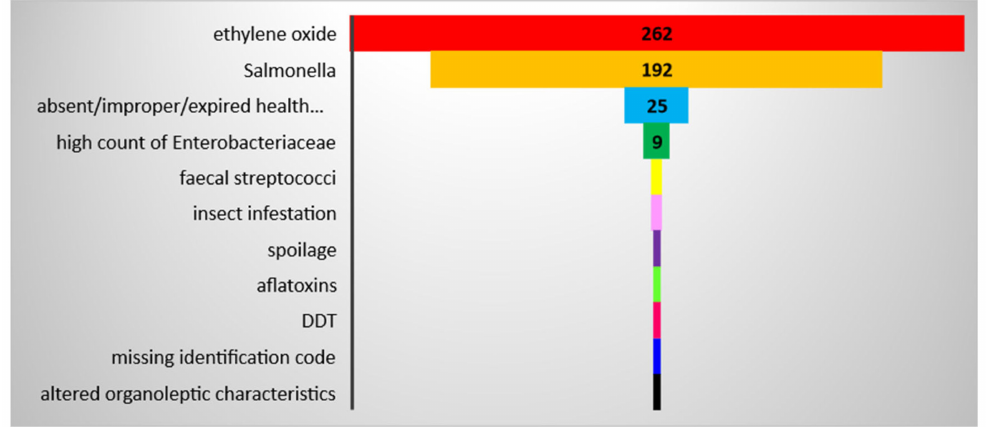
Figure 2. RASFF notifications linked to sesame seeds from India per substance/hazard over the period 1 January 2011–31 December 2020: the aggregated data at the period of analysis level (Source: Own elaboration based on